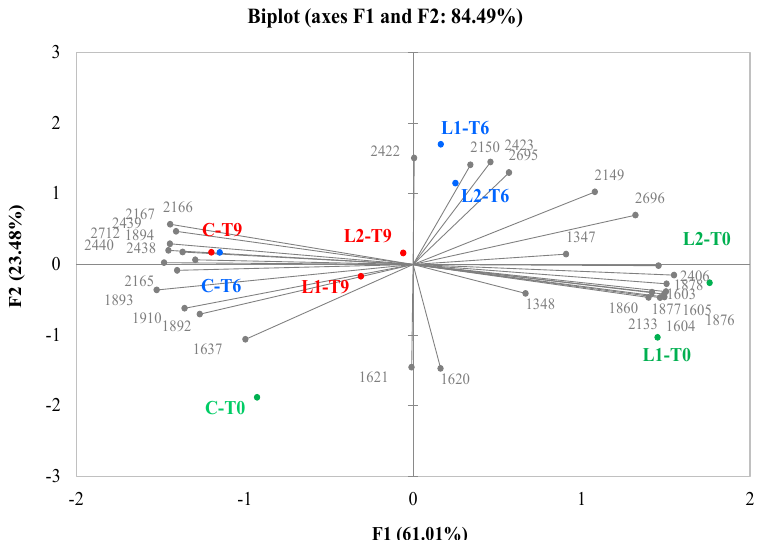
Figure 2. Representation of the cases and variables obtained from the PCA related to the results of the image analysis (electronic eye) for the three samples under examination (C, Control (minced beef meat + maltodextrine + starter cultures); L1, minced beef meat + starter cultures + 87.5 mg phenols/kg of meat; L2, minced beef meat + starter cultures + 175 phenols/kg of meat) evaluated at all of the storage times (T0, T6, and T9).